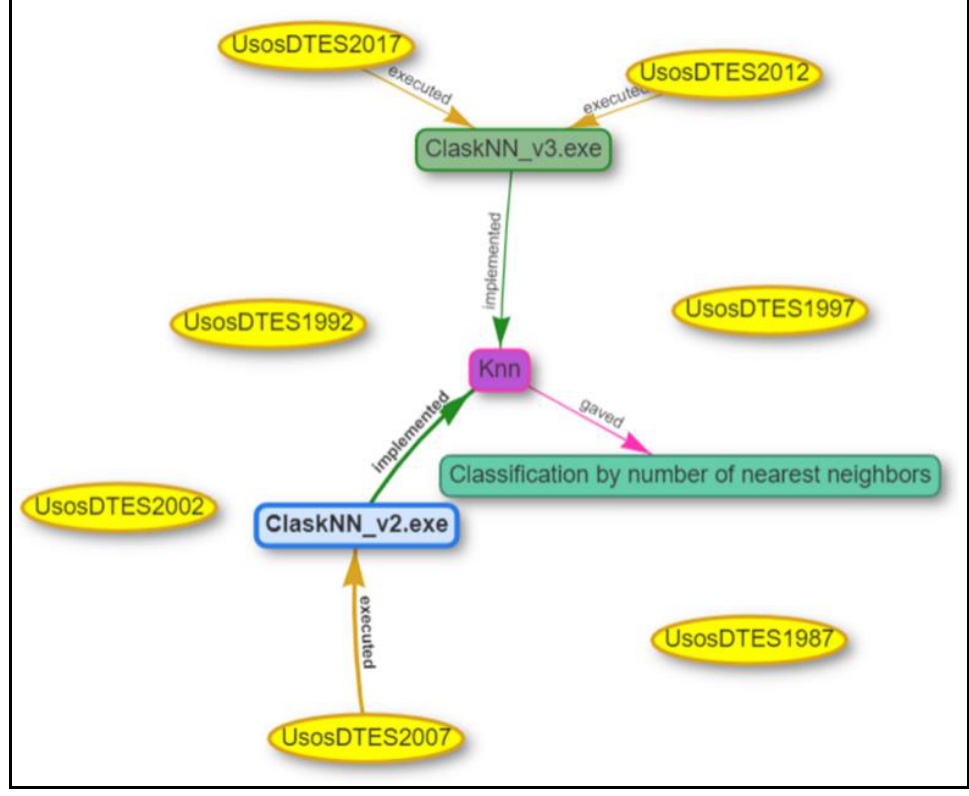
Figure 13. Query example and result: Over the complete MCSC dataset series, which versions have been generated using kNN algorithms? (Q29 in Table 4).